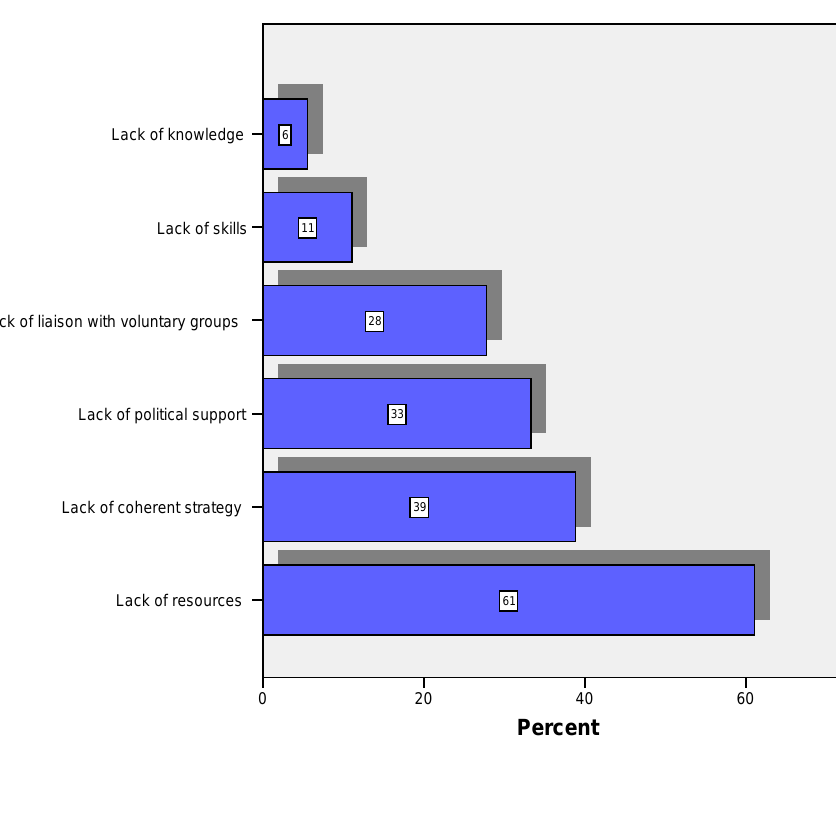
Figure 3. Obstacles to IFEH Organisation in Addressing Tobacco Control